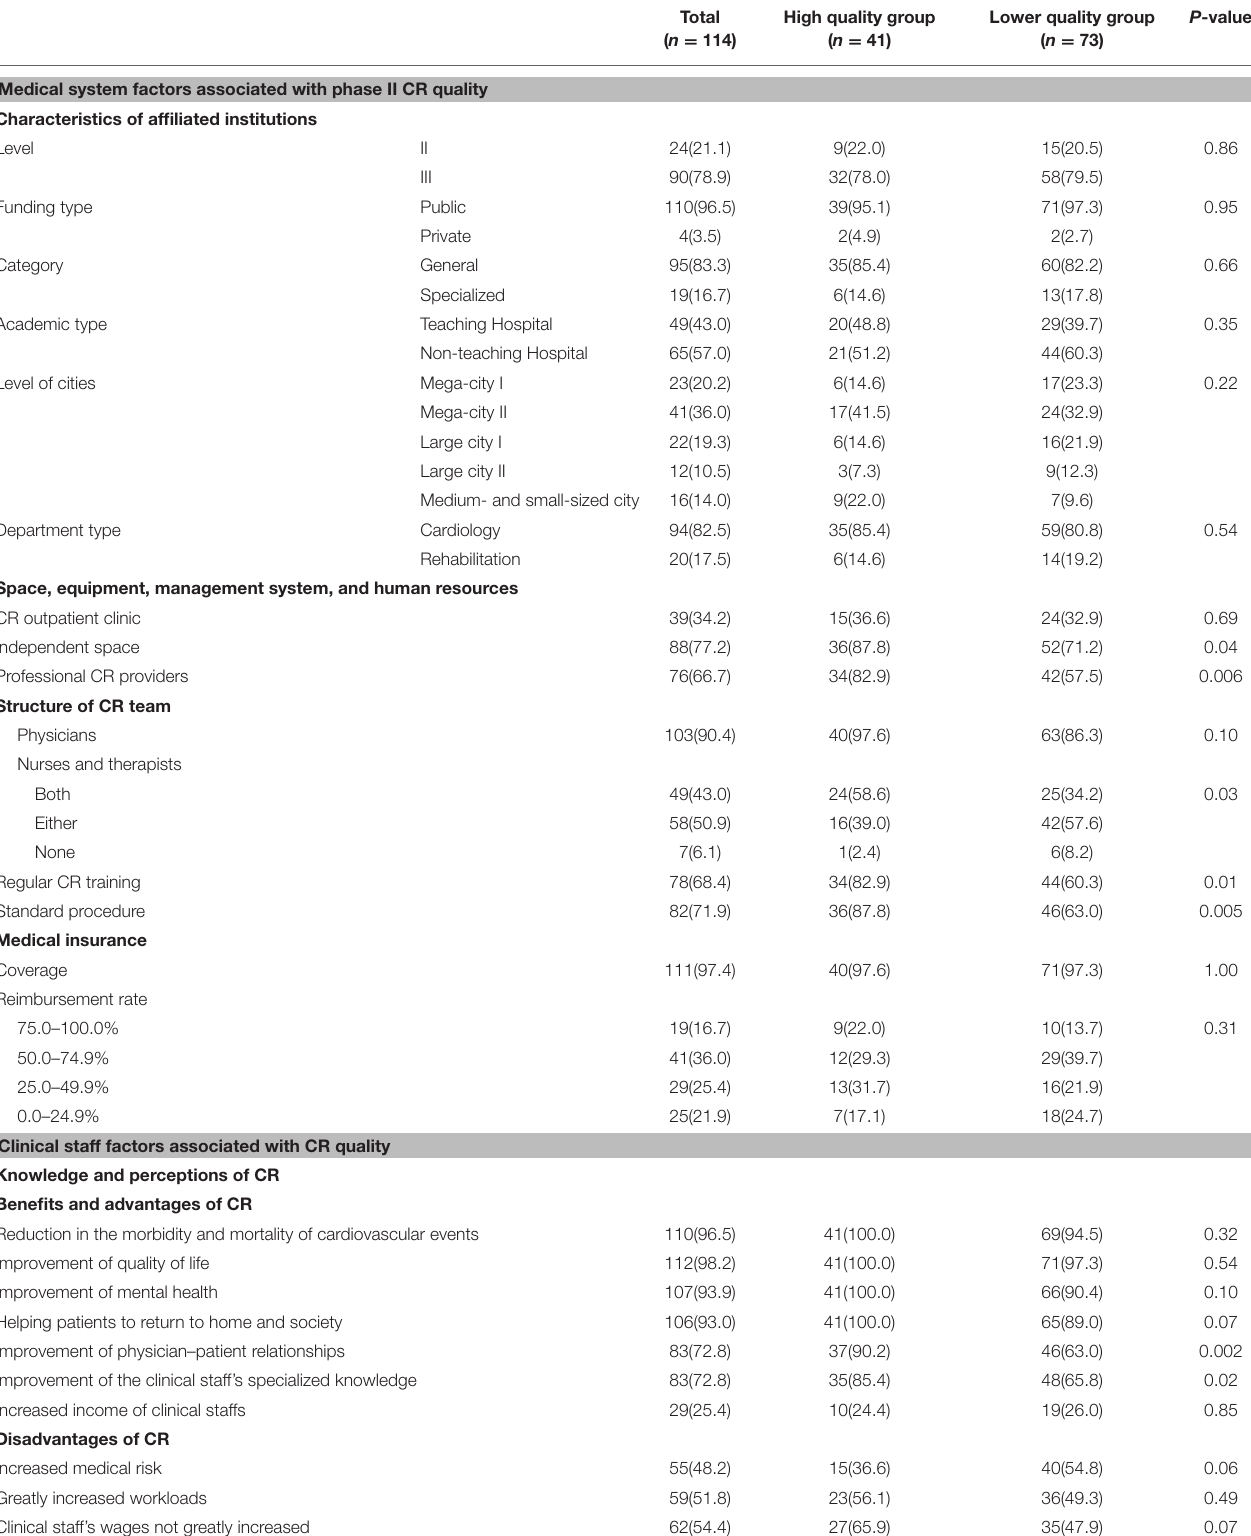
TABLE 2 | Factors associated with phase II CR quality during implementation and